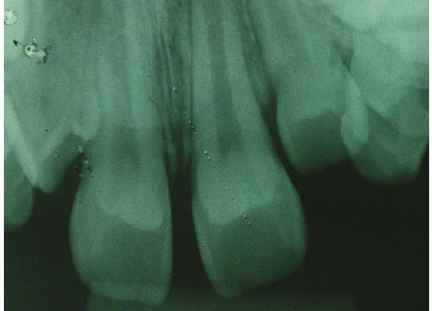
Figure 6: Final radiographic